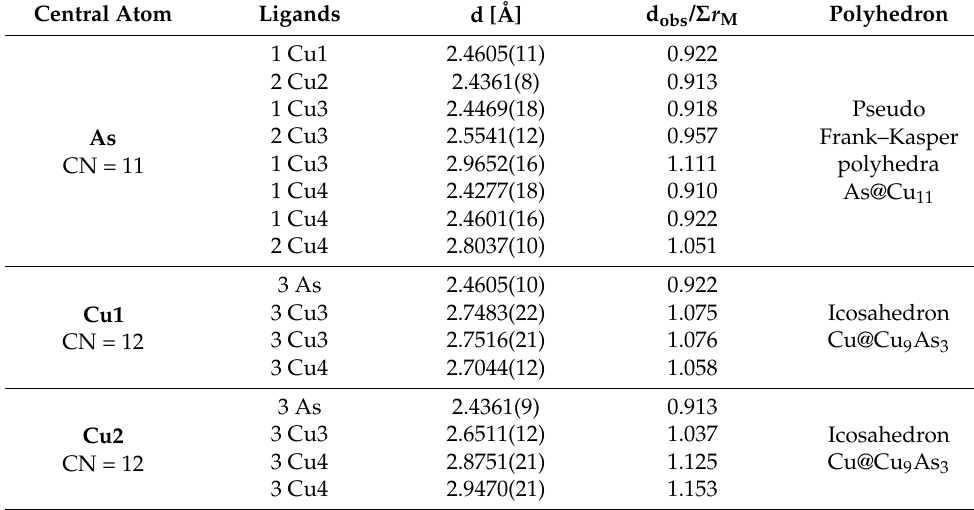
Figure 6. Perspective drawing of the RT structure of the Cu 3 As compound. Each unit cell contains two layers, α and β , of vertex-sharing triangular ‘Cu 3 As’ units. Orange and green balls indicate Cu and As atoms, respectively.